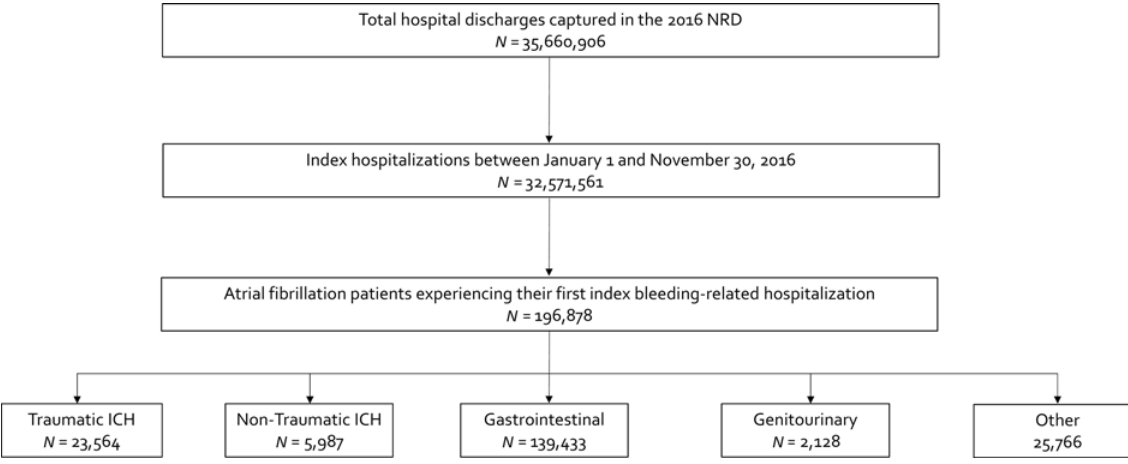
Fig. 1 Flow diagram of patient